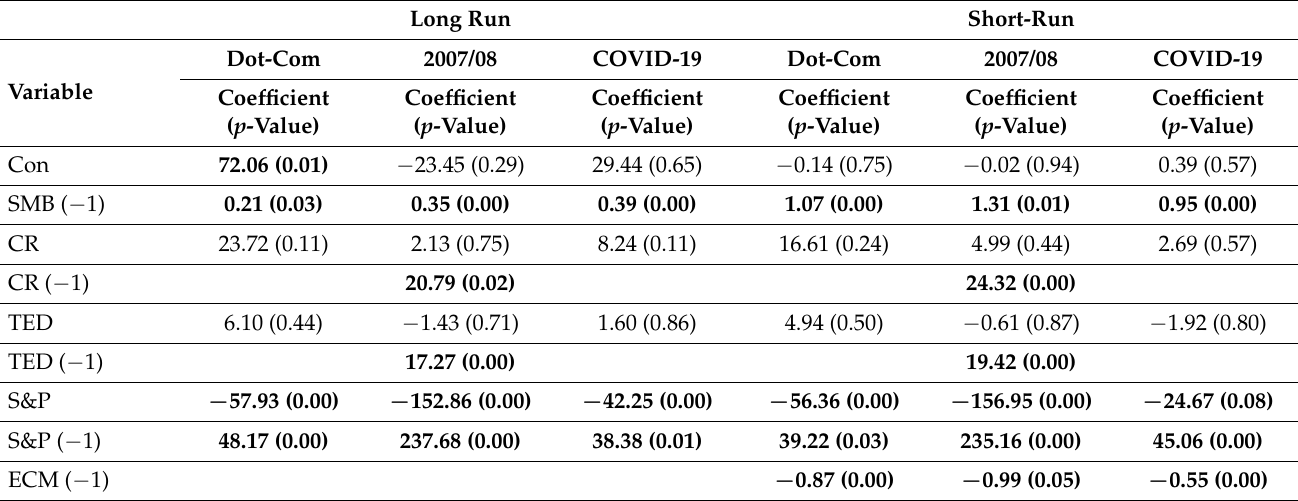
Table 15. Long-run ARDL model and short-run error correction model for SMB